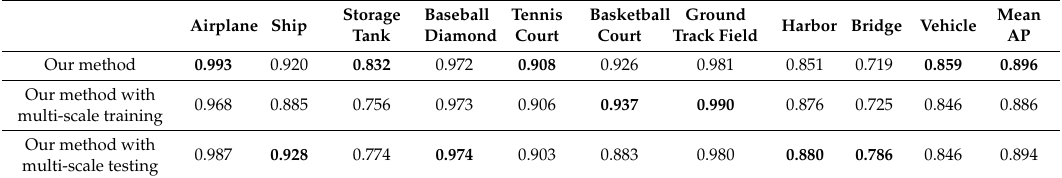
Table 8. The AP values of the object detection strategies.